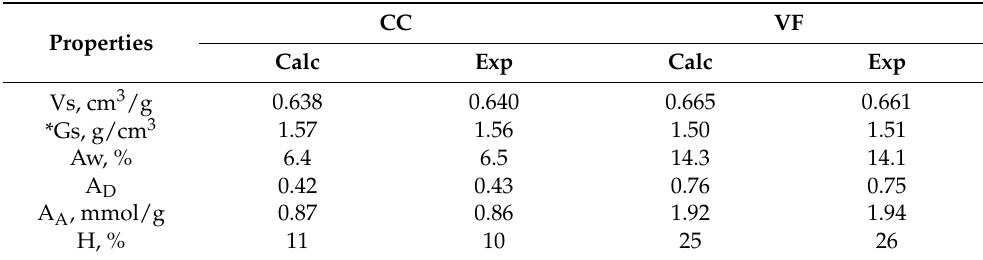
Table 5. Some properties of CC and